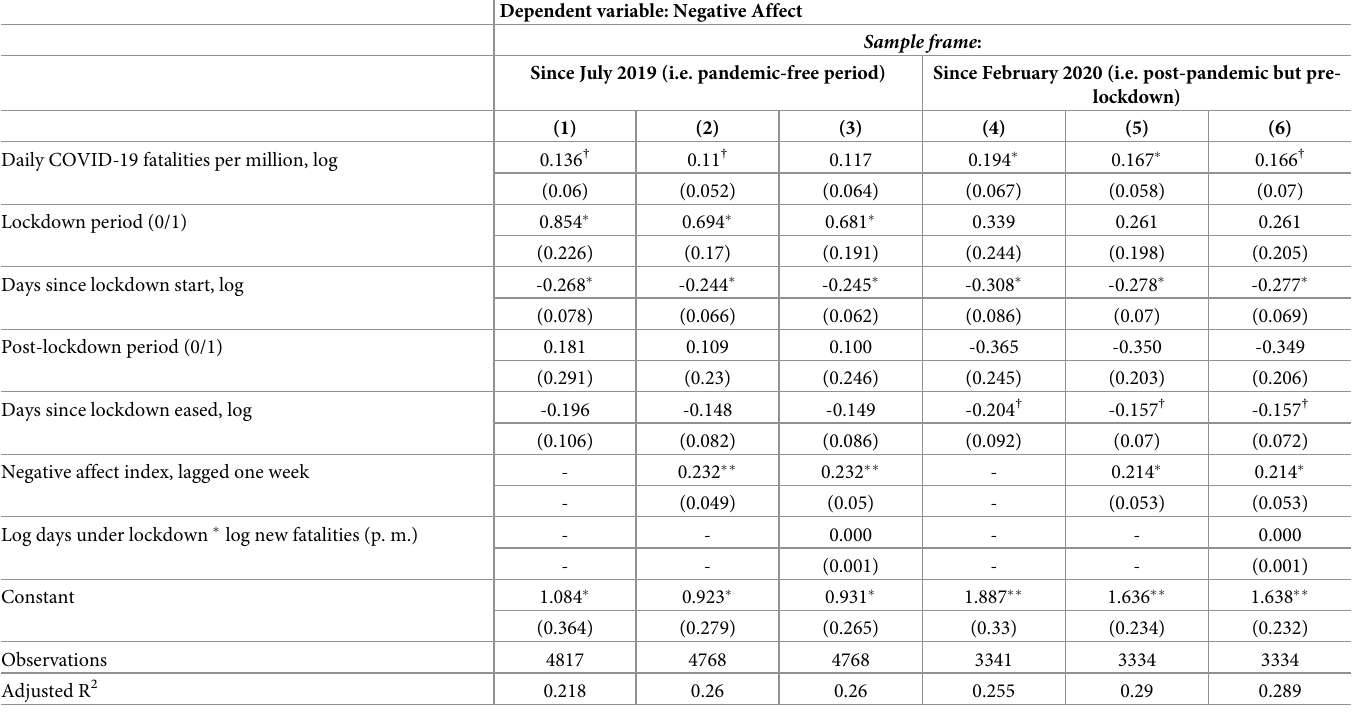
Table 2. Negative affect under lockdown: Time-series